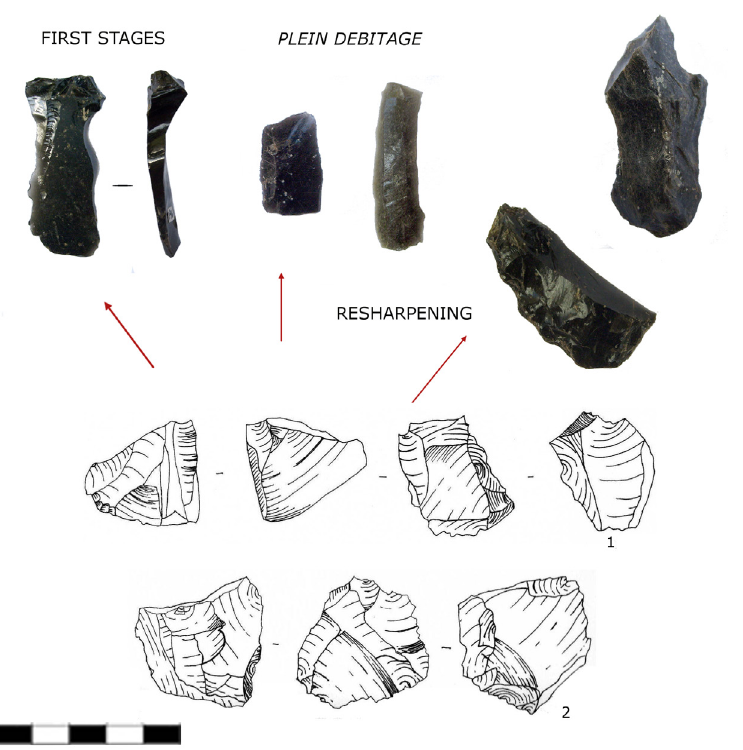
Figure 9 . S. Martino. Chaîne opératoire of the obsidian assemblage from Stentinello levels. In the lower part there are two polyhedral